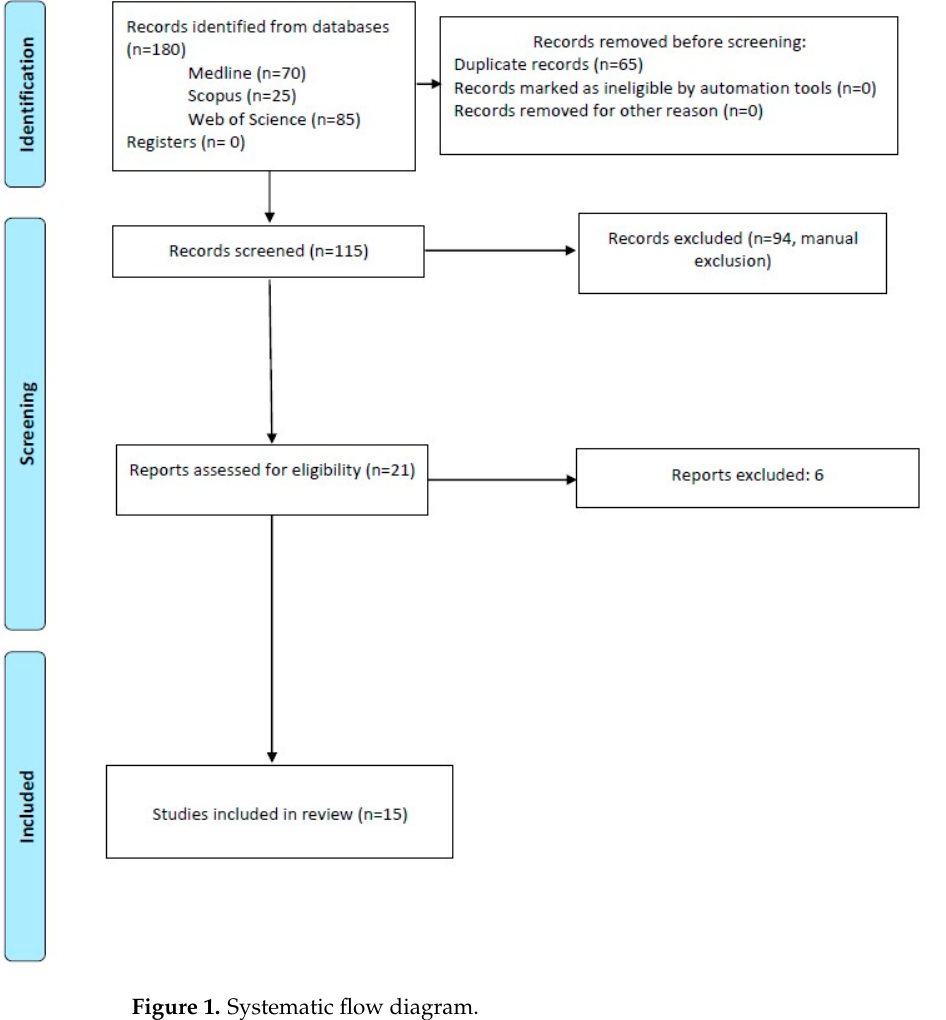
Figure 1. Systematic flow diagram.